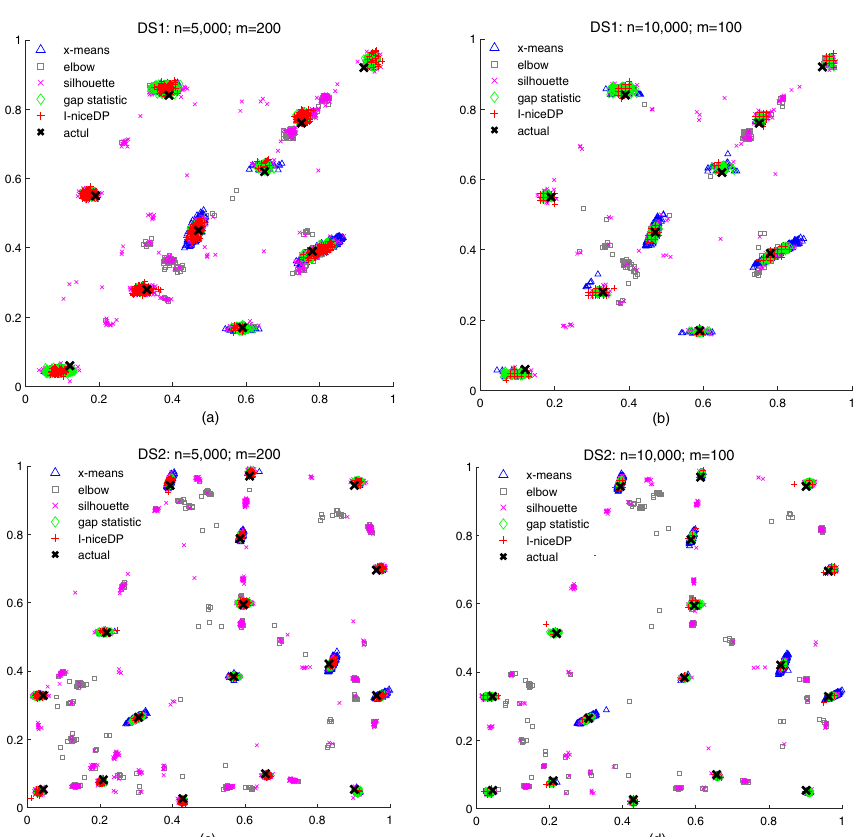
Fig. 4 Scatter plots of identified centers in random samples of different sizes, achieved by different algorithms from DS1 ( a and b ) and DS2 ( c and d ) datasets. The centers estimated by the algorithms are indicated by distinct symbols and